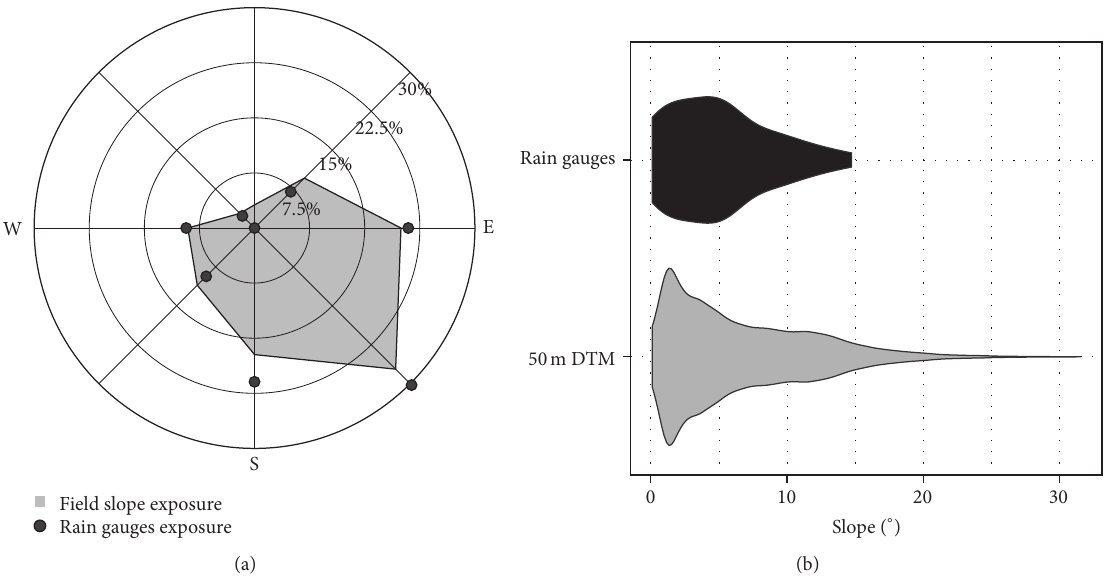
Figure 2: (a) Field slope exposure (grey surface) and rain gauge exposure (dark grey points). (b) Slope distribution over the study area. The black zone represents the distribution of HydraVitis rain gauges in relation to topography. The grey zone represents slope distribution for 50 m